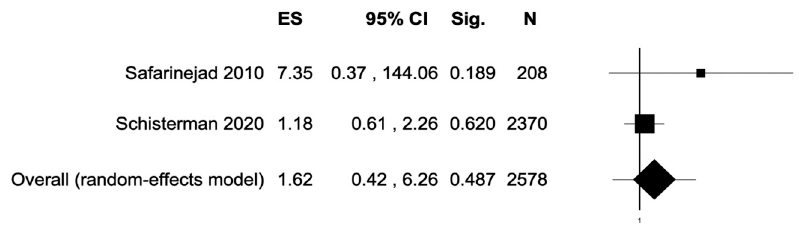
Figure 4. Forest plot showing the OR for pruritus. ES, effect size; CI, confidence interval. (I2 = 27.82, p = 0.239).